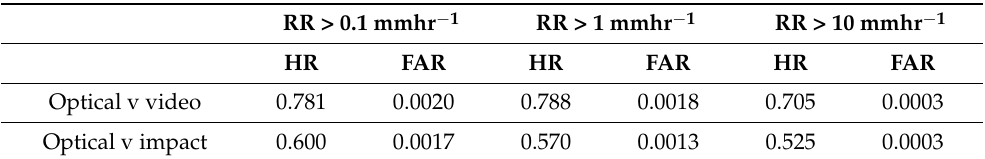
Figure 16. Scatterplots of 1 min rainfall rates (RR, in mmhr − 1 ) from the three disdrometers operating at US SGP. The optical disdrometer (OTT Parsivel 2 ) is shown in the x -axis and the red and blue dots show all 1 min periods when the video (red) or impact (blue) disdrometers also show RR above the specified threshold; ( a ) 0.1 mmhr − 1 , ( b ) 1 mmhr − 1 and ( c ) 10 mmhr − 1 . Panels on the right show the mean droplet size distributions for those same 1 min periods. Two values are shown for each diameter for the optical disdrometer, they denote conditional sampling for co-occurrence of the specific RR in the video and impact disdrometers. The values shown in the legends of the left-hand panels denote the Spearman (rank) correlation coefficients (r s ) and the sample size (n). Hit Rates (HR) and False Alarm Rates (FAR) for the co-occurrence of RR above the specified thresholds are given in Table 4. Table 4. Hit Rates (HR) and False Alarm Rates (FAR) for the co-occurrence of RR above the specified thresholds from the optical, impact and video disdrometers operating at the DoE ARM site in the Southern Great Plains (SGP). See also Figure 16.